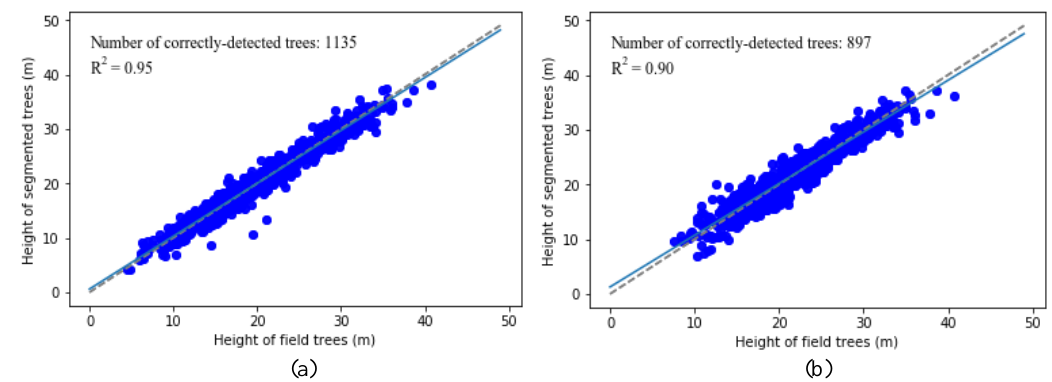
Figure 14. LiDAR-derived vs. on-site measured tree heights for all correctly-detected trees. ( a ) Multi-threshold and ( b ) DSM-based. The dashed line denotes a hypothetical 1:1 ratio between LiDAR-derived and on-site measured.